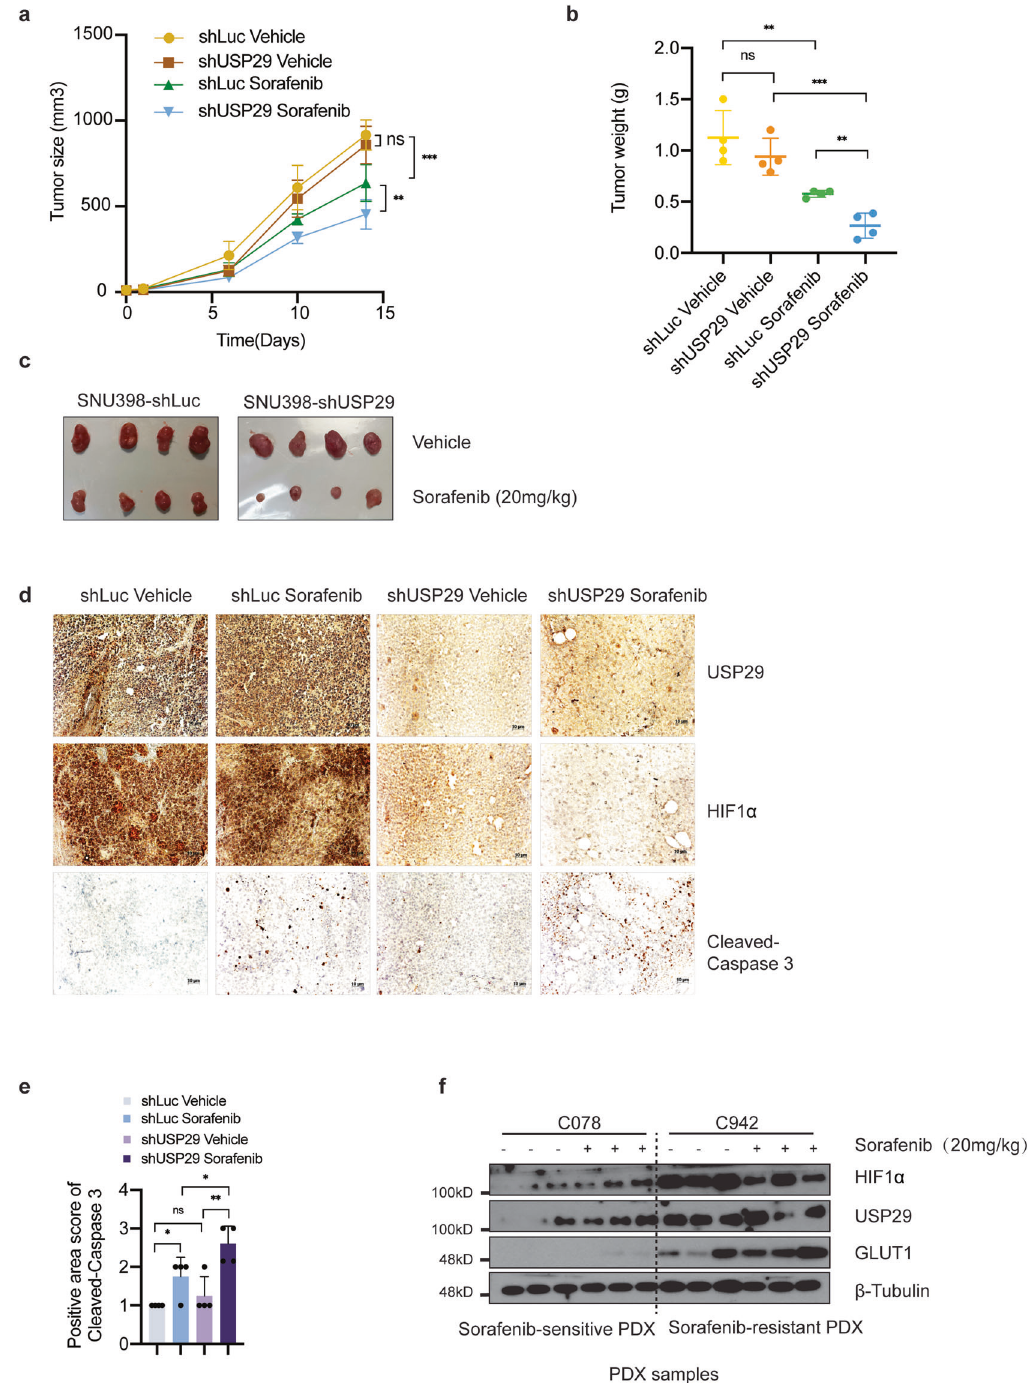
Fig. 6 USP29 regulates responses to Sorafenib treatment in vivo. a – c Xenotransplanted HCC is re-sensitized to Sorafenib treatment upon depletion of USP29. Sorafenib-resistant SNU398 cells expressing either a control shRNA (shLuc) or a shRNA against USP29 (shUSP29) were implanted into the fl anks of immunode fi cient NSG mice and treated with vehicle solution or Sorafenib, respectively. Tumor growth curves over time ( a ) and tumor weights at the time of sacri fi ce ( b ) were determined, N = 4. Images of the tumors at the time of sacri fi ce are shown in ( c ). ns not signi fi cant; ** P < 0.01; *** P < 0.001; Two-way ANOVA. d , e USP29-de fi cient tumors exhibit higher rates of apoptosis upon Sorafenib treatment. Histological sections of the tumors described in ( a – c ) were immunostained for USP29 and HIF1 α ( d ). Immunostaining for cleaved Caspase 3 was used to quantify apoptosis ( d , e ). f Sorafenib-resistant PDX tumors present high USP29, HIF1 α , and GLUT1 protein levels. Tumor pieces of HCC patient-derived xenotransplanted (PDX) mice which have been previously classi fi ed as Sorafenib-responsive or Sorafenib- resistant were analyzed by immunoblotting for the expression of HIF1 α , USP29, and GLUT1. Immunoblotting for β -Tubulin was used as loading control. Results represent three independent